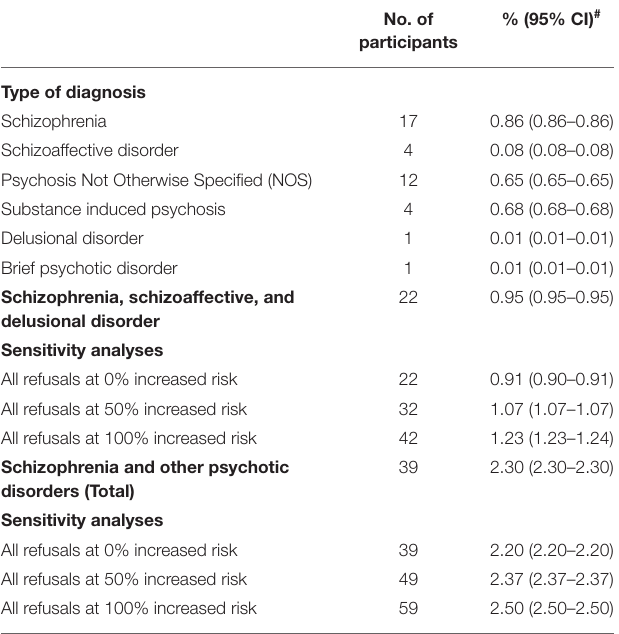
TABLE 3 | Sociodemographic correlates of lifetime schizophrenia and other psychotic